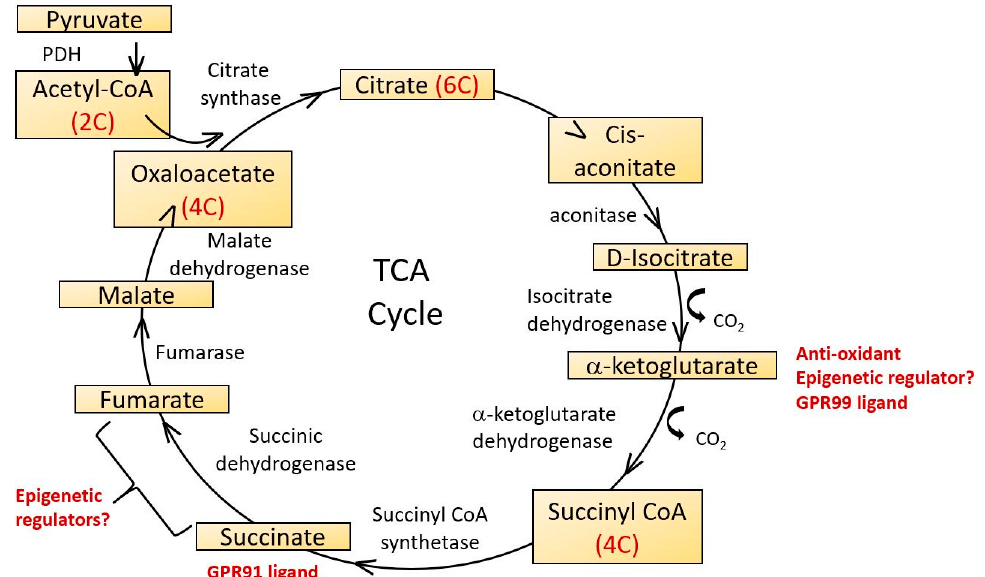
Figure 4. The tricarboxylic acid cycle (TCA), also known as the citric acid cycle of Krebs cycle occurs in the mitochondrial matrix. It functions to supply ATP, NADH and biochemical intermediates for a variety of metabolic pathways. 2-carbon acetyl CoA derived from glycolytic pathways reacts with 4-carbon oxaloacetate in the first step and a linked series of reactions results in the synthesis of two carbon dioxide molecules, three NADH, one FADH2 and one ATP molecule per cycle, regenerating oxaloacetate as it does so. Several TCA cycle intermediates have potential roles as epigenetic regulators and ligands for G protein coupled receptors. 2-Oxoglutarate is also known as α - ketoglutarate.